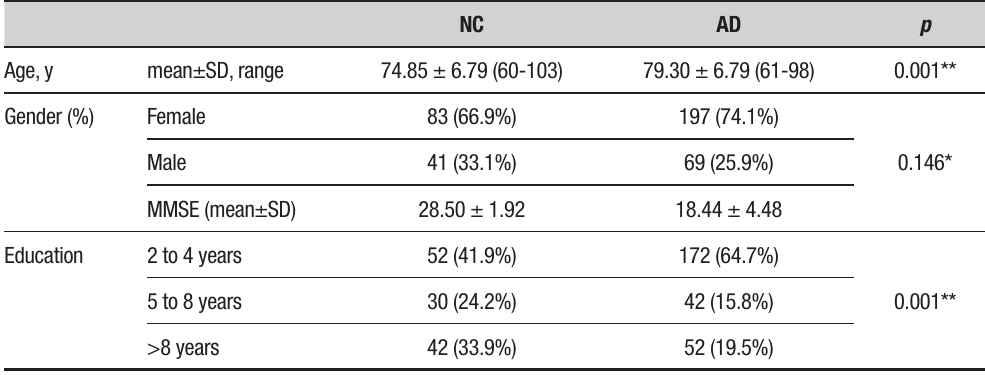
Table 1. Characteristics of the sample regarding age, sex and education.